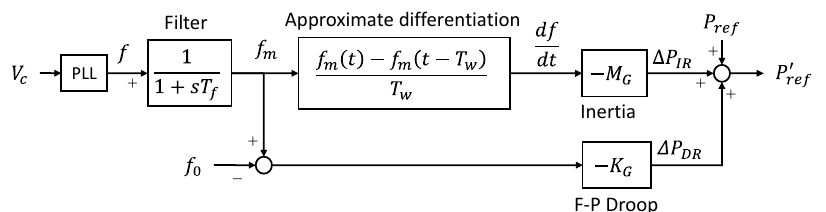
Figure 7. Controller model of the grid-following virtual inertia control (VI-GFL) used in a part of the simulation in Step 3.